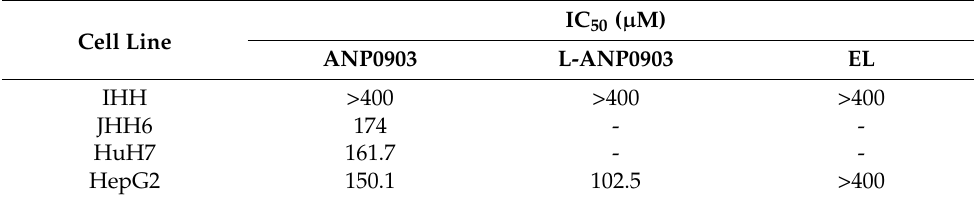
Table 3. The half-maximal inhibitory concentration (IC 50 ) values of ANP0903 and of its liposomal formulation (L-ANP0903) tested on human hepatocarcinoma cell lines. Empty PEG-liposomes (EL) were tested as a control to evaluate the cytotoxicity of the nanocarrier.